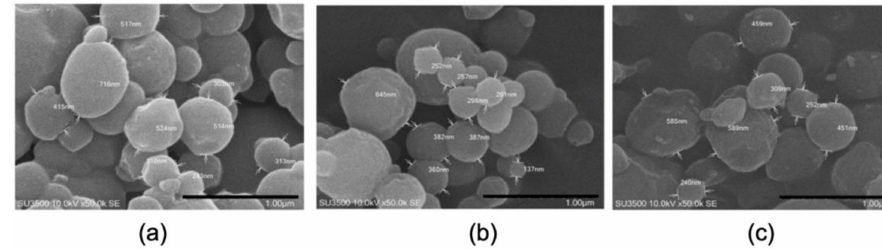
Figure 2. SEM images of ( a ) F1, ( b ) F2, and ( c ) F3.